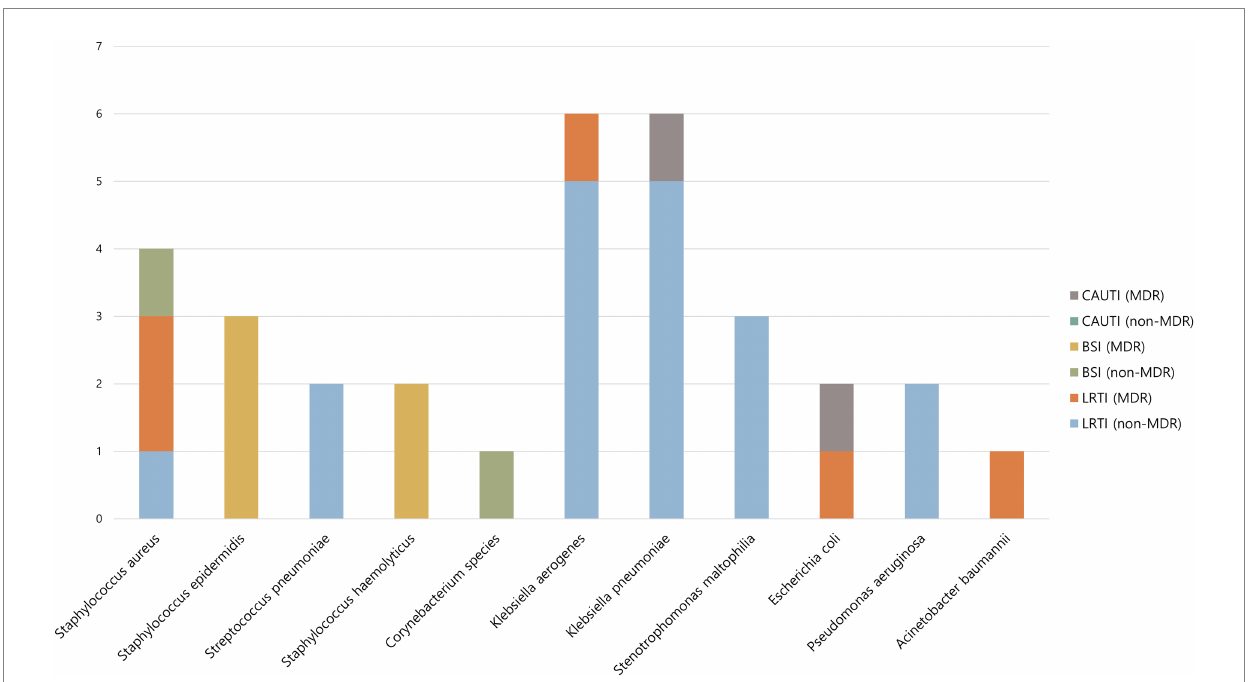
FIGURE 2 Causative microorganism of bacterial superinfection according to site of infection and MDR status. MDR, multidrug-resistant; CAUTI, catheter- associated urinary tract infection; BSI, bloodstream infection; LRTI, lower respiratory tract infection.